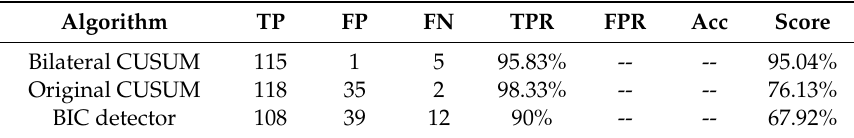
Table 9. The performance of di ff erent event detection algorithms on the reference energy disaggregation dataset (REDD).